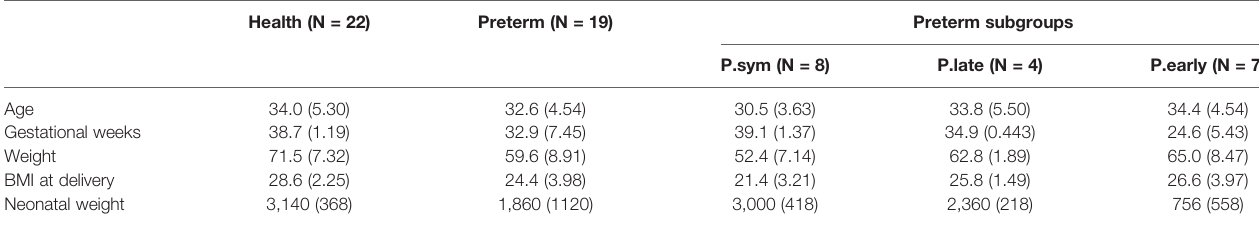
TABLE 1 | Characteristics of the study